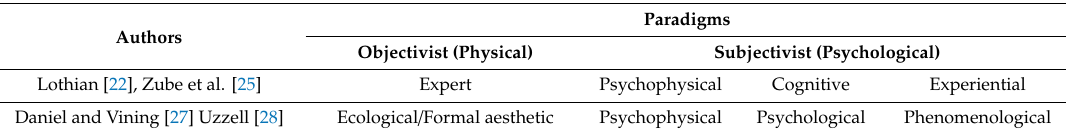
Table 1. Paradigms of landscape perception